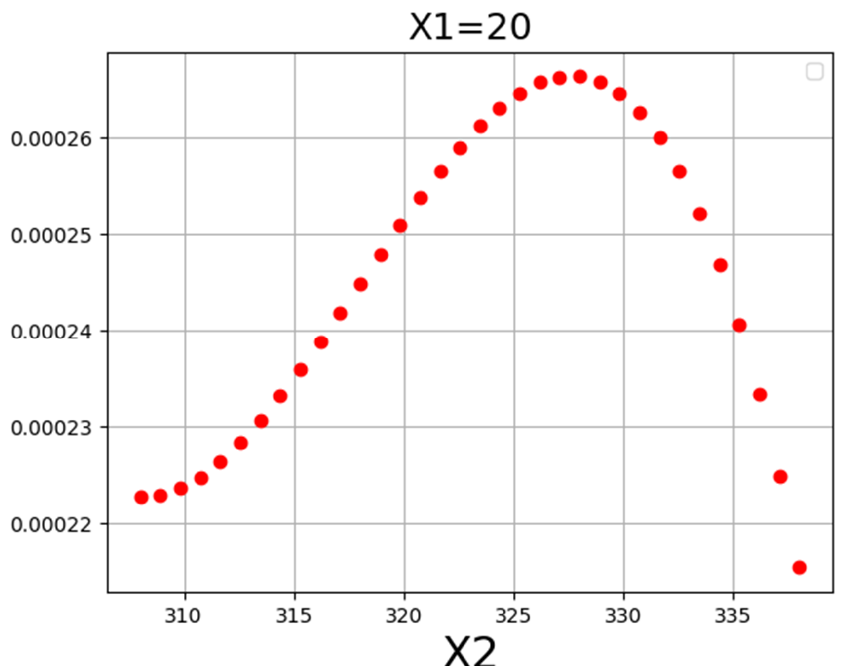
Figure 6. X2 tendency. Table 5. Final attributes amount for the supreme